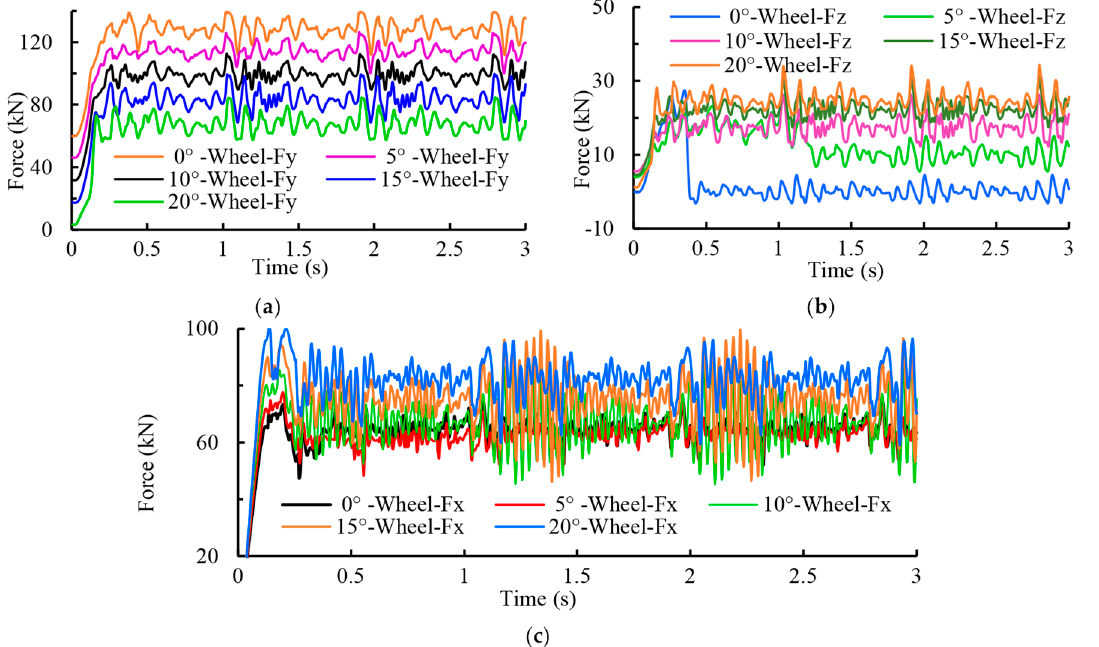
Figure 9. Mechanical property of the walking wheel under different depression angle: ( a ) The supporting force in y-direction; ( b ) The axial force in z-direction; and ( c ) The traction force in x-direction.